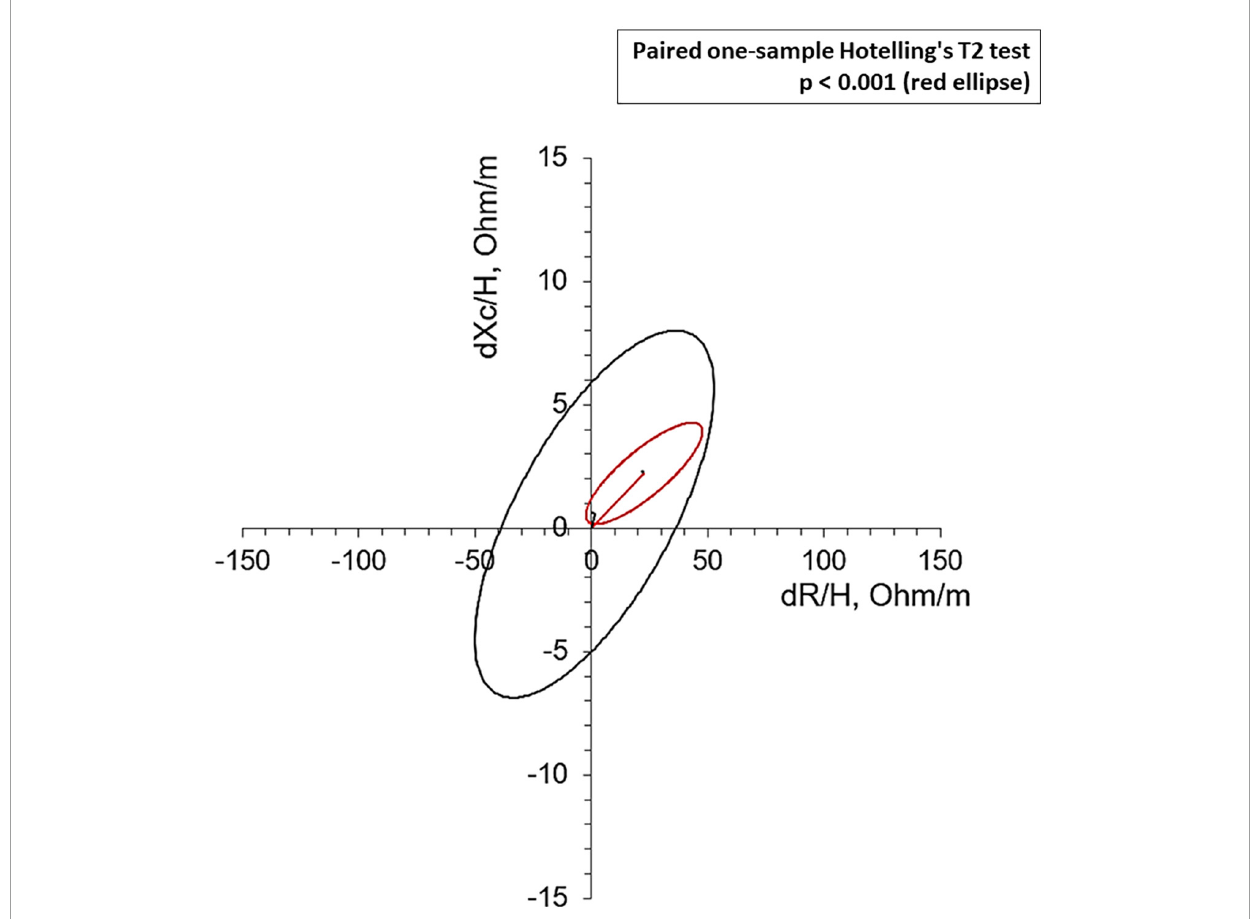
FIGURE4 Mean Biavectors’ displacement, between the day before the start of SGLT2i (T0) and 90 treatment days (T90), from overhydrated (red ellipse, p < 0.001) and normohydrated patients (black ellipse, not significant), compared with the paired one-sample Hotelling’s T2